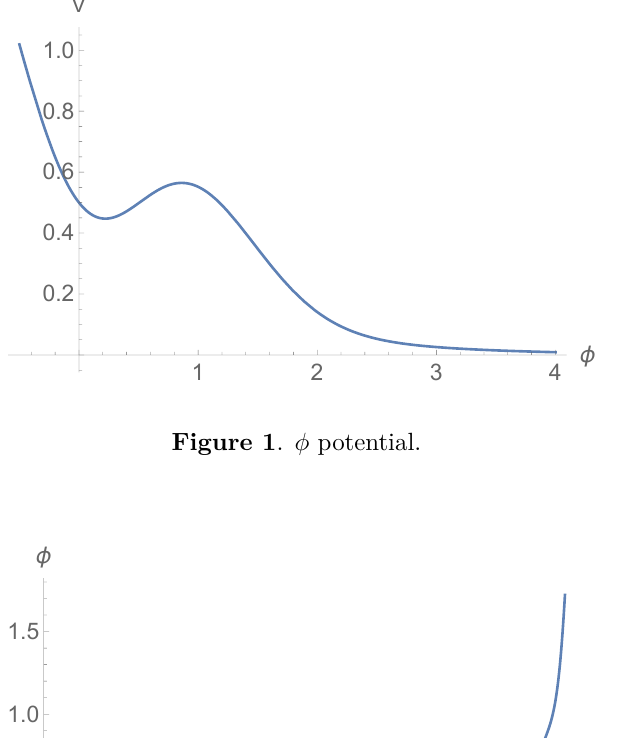
Figure 1 . φ potential.